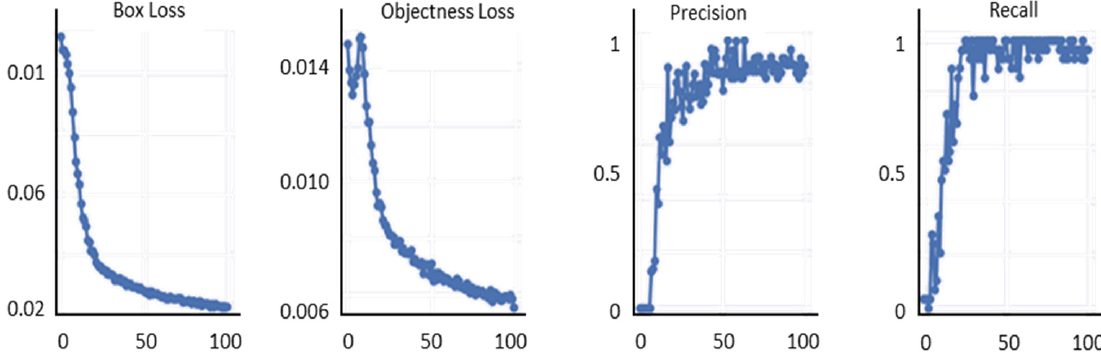
Figure 11. Plots of box loss, objectness loss, precision, and recall over the epochs for the training and validation dataset.